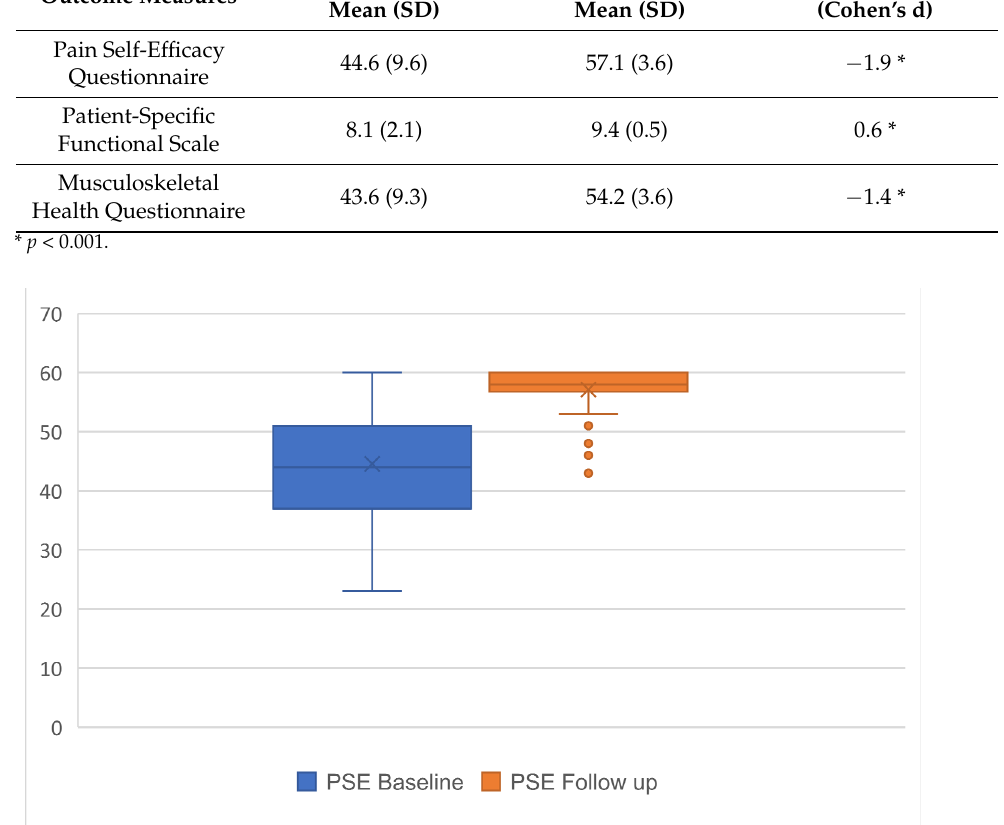
Figure 1. Boxplot of mean and SD for Pain Self-efficacy (PSE) scores at baseline and follow-up.